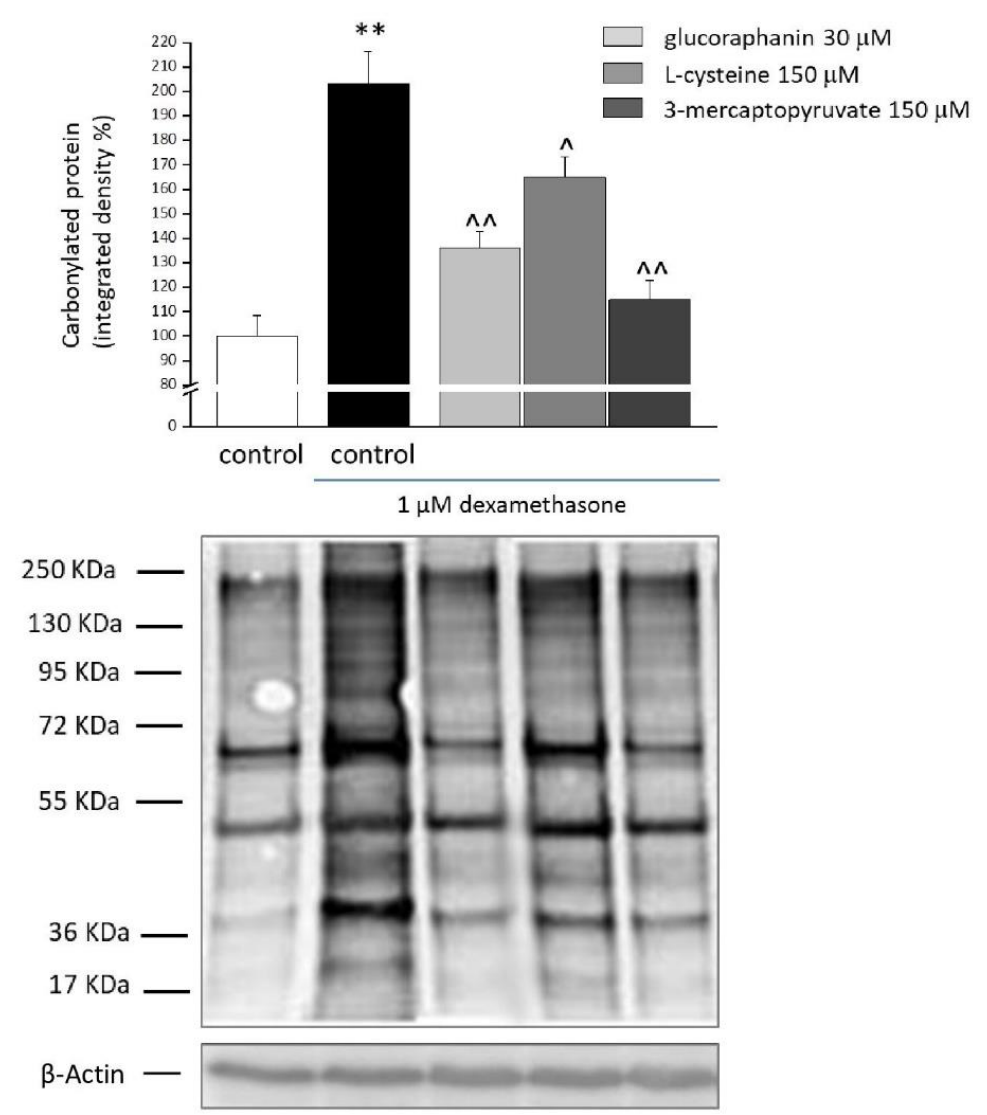
Figure 5. Protein carbonylation in C2C12 myotubes. C2C12 myotubes were treated for 48 h with 1 µ M DEX, both alone and in the presence of 30 µ M glucoraphanin, 150 µ M L-cysteine, and 150 µ M mercaptopyruvate. Western blot analysis was carried out on cell homogenates using a specific anti- body against DNPH. Figures show the densitometric analysis ( top ) and the illustrative immunoblot ( bottom ). Each sample was normalized to GAPDH expression. Values are expressed % of integrated density and calculated as mean ± S.E.M. of 3 different experiments. ** p < 0.01 versus control; ^ p < 0.05 and ^^ p < 0.01 versus DEX.